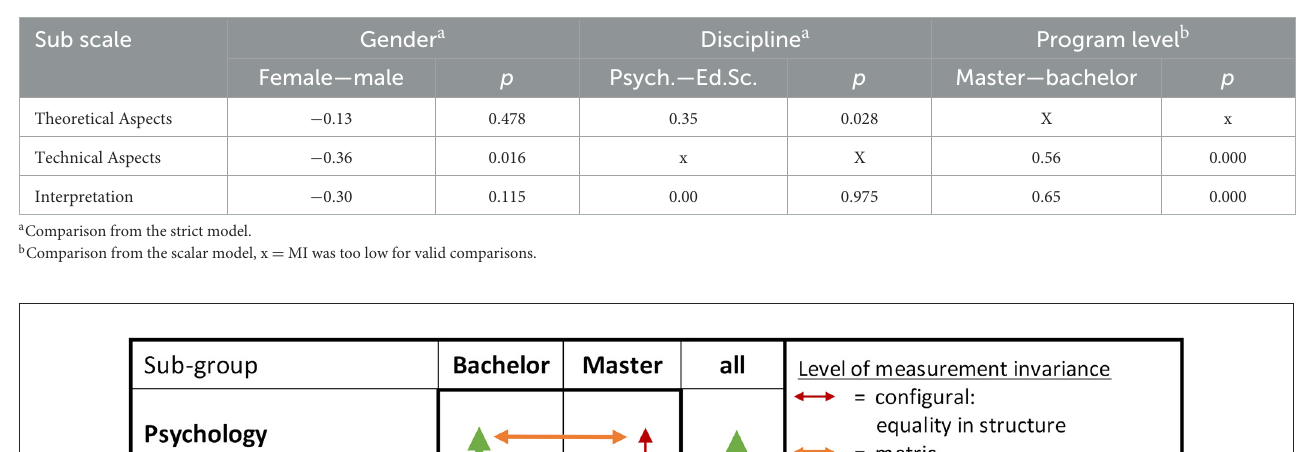
TABLE 2 Latent mean comparisons on ASER sub-factors for gender, discipline, and program level.